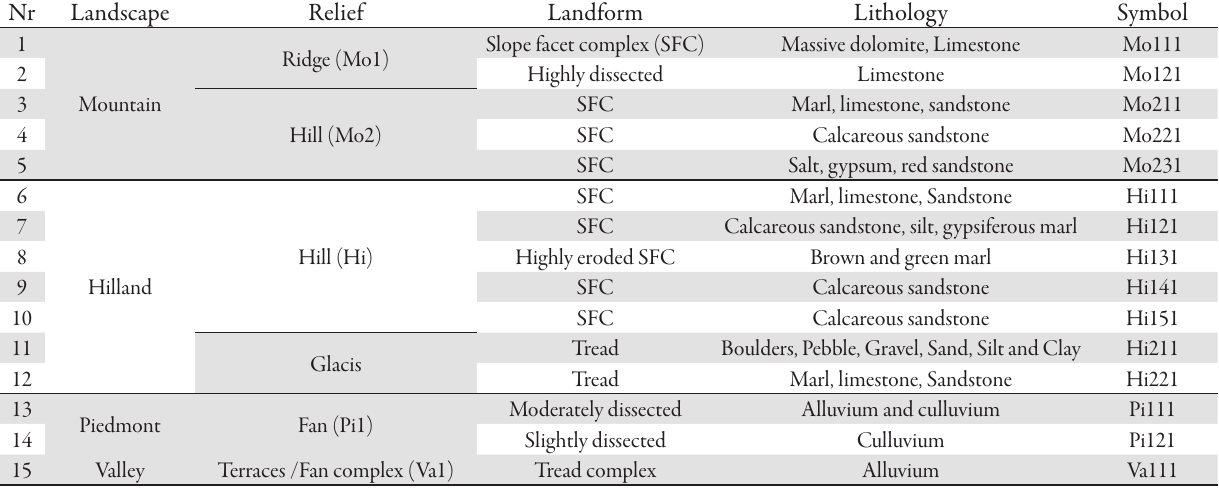
Tab. 1. Legend of TMU of the study